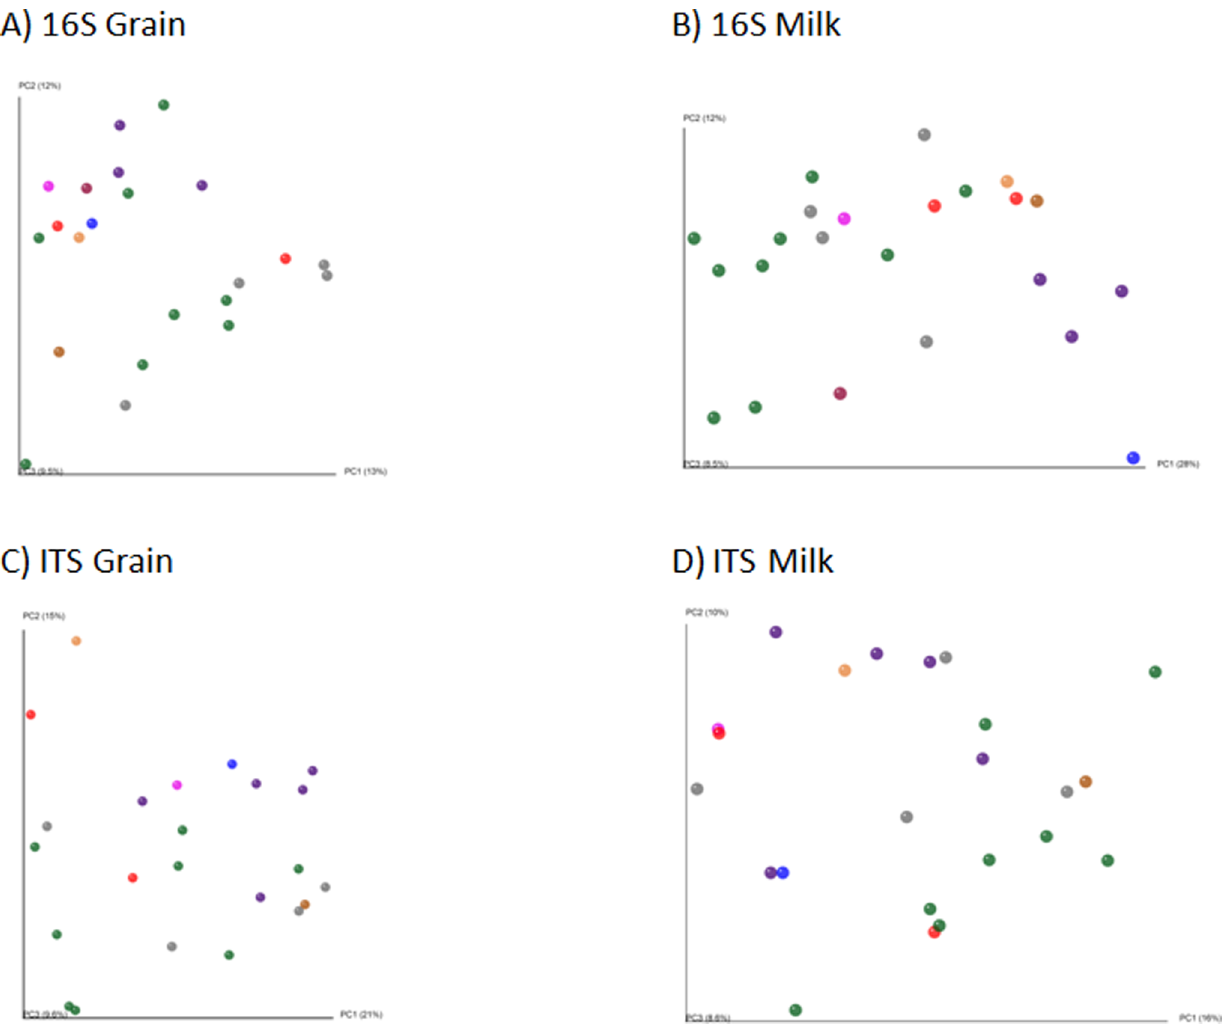
Figure 1. Principle Coordinate Analysis (PCoA) plots, based on unweighted UniFrac distance matrices, show the diversity within bacterial populations from kefir grains (A) and kefir fermented milk (B) and fungal grain (C) and milk (D) populations. Green=Irish kefir, Orange=Belgian kefir, Light Brown=Spanish kefir, Red=German kefir, Grey=US kefir, Pink=Italian kefir and Purple=UK kefir.